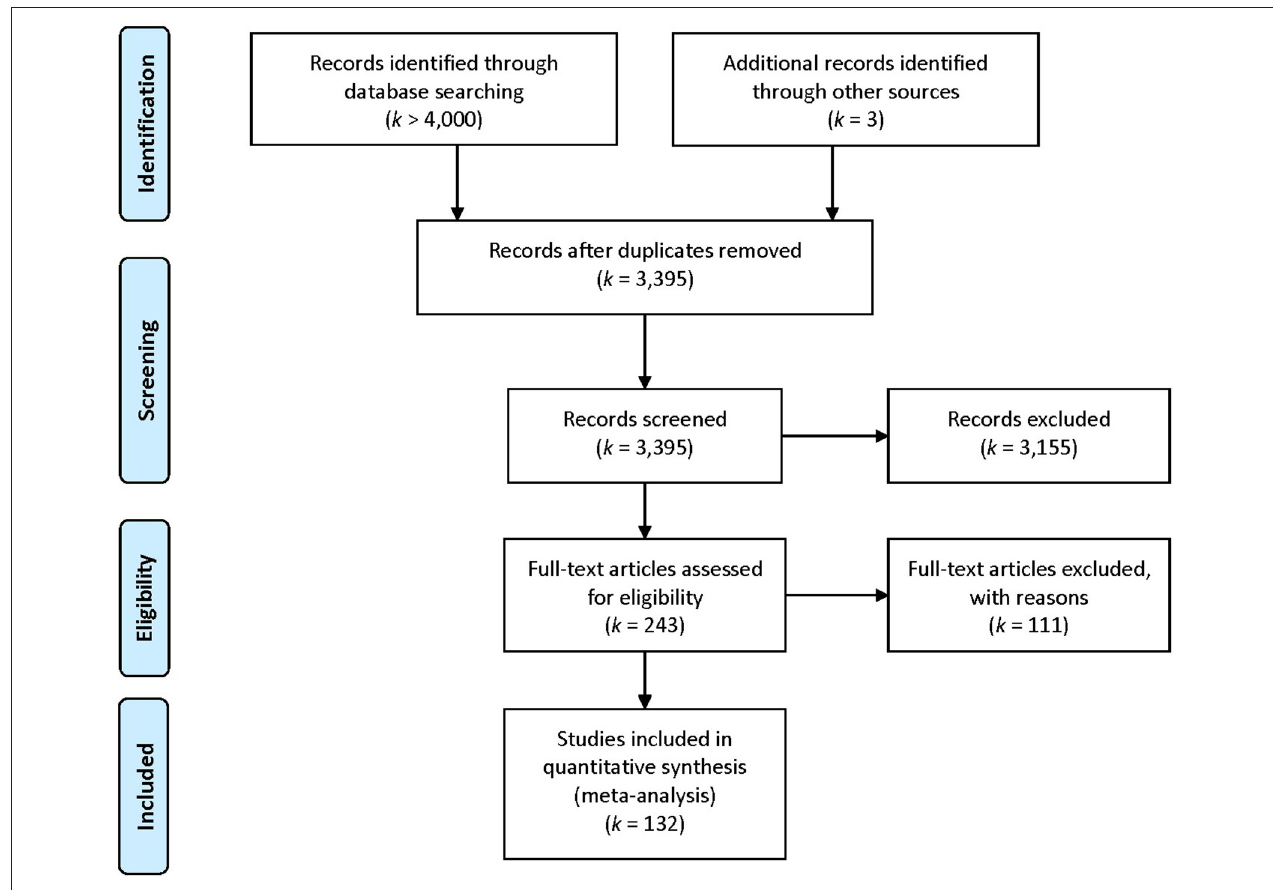
FIGURE 3 | Primary study flow chart depicting numbers of excluded and included